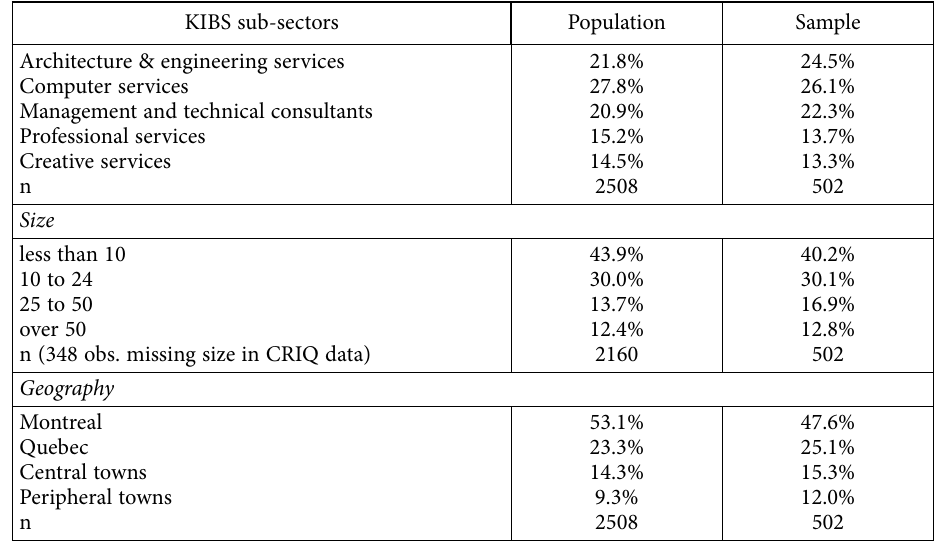
Table 1A. Population and sample